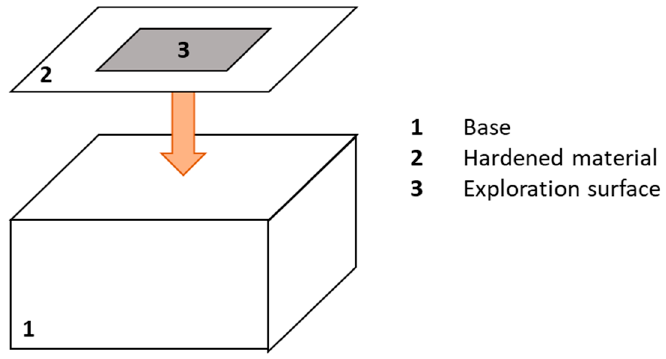
Figure 2. Roughness standard components [21,22].